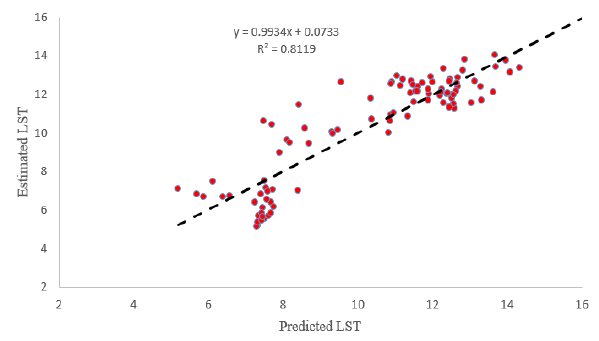
Figure 6. Scatterplot of the predicted and estimated LST